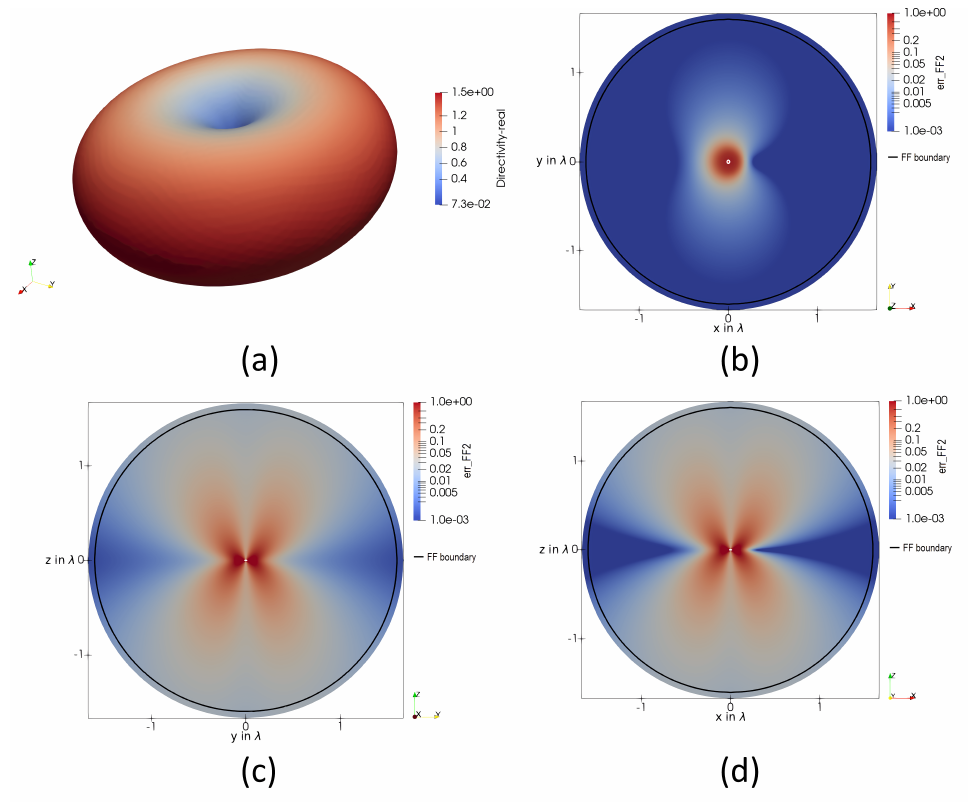
Figure 20. ( a ) A 3D plot of the directivity D ( θ , φ ) of a loop antenna with the circumference of C = 0.1 λ . The error-estimator 6, describing a qualitative measure of the FF quality, applied on a loop antenna with the circumference of C = 0.1 λ in the ( b ) xy-plane, ( c ) yz-plane, and ( d ) zx-plane. The FF boundary r far for the given antenna dimension l = C given in 4 is displayed as a black π